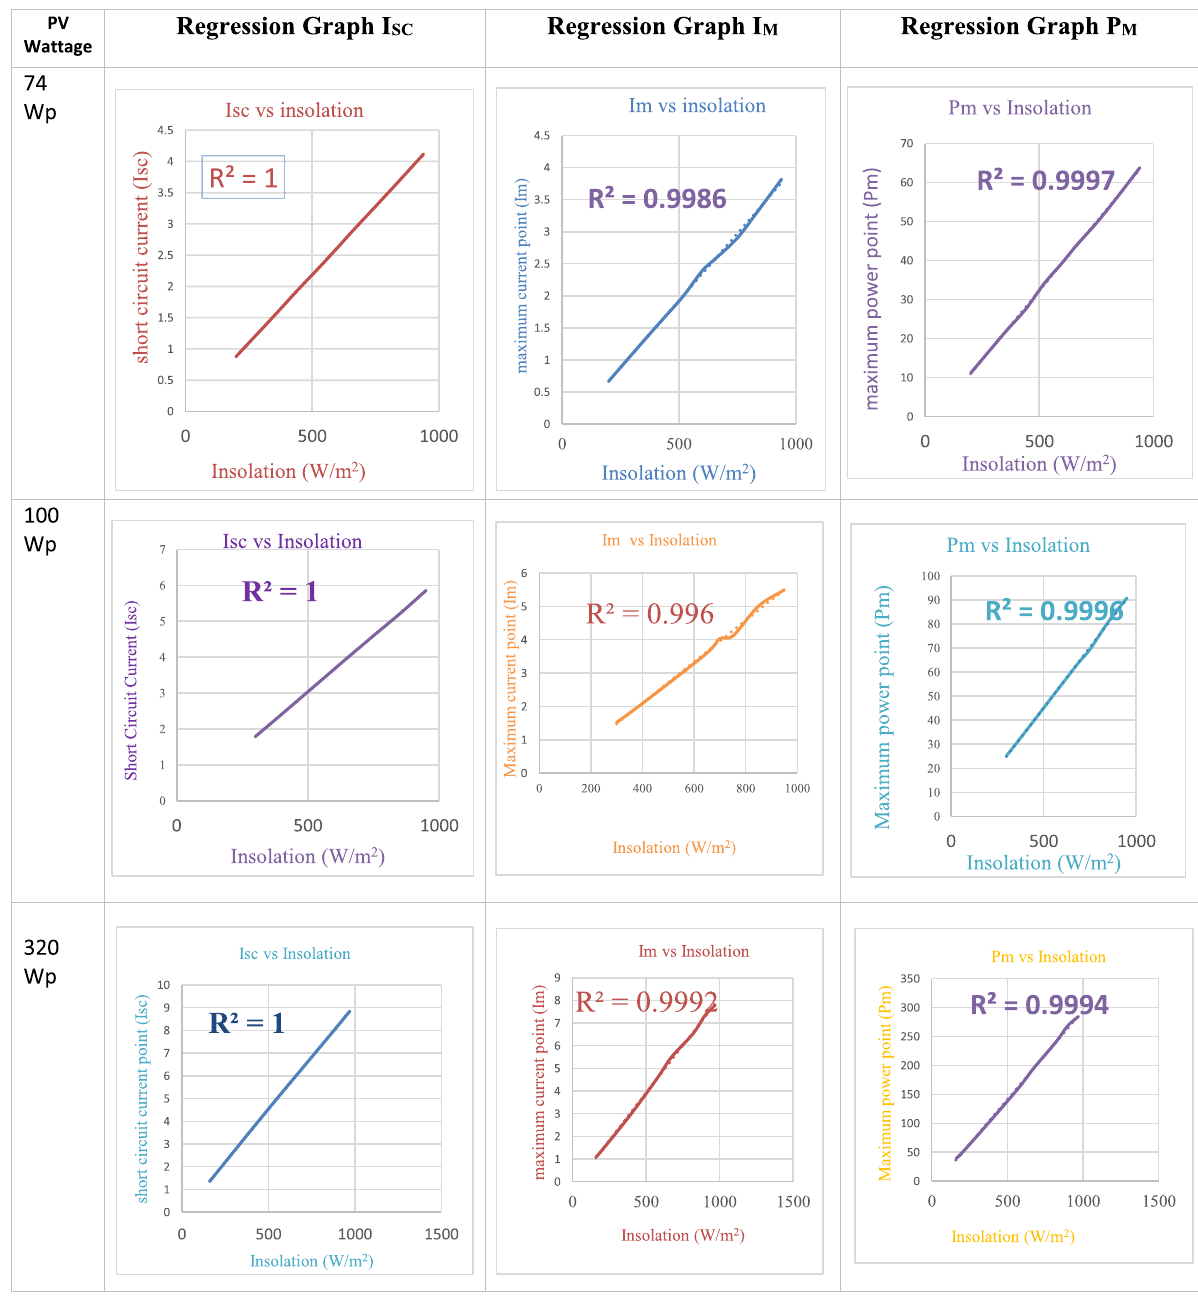
Fig. 4. Linearity check for the solar PV parameters against insolation